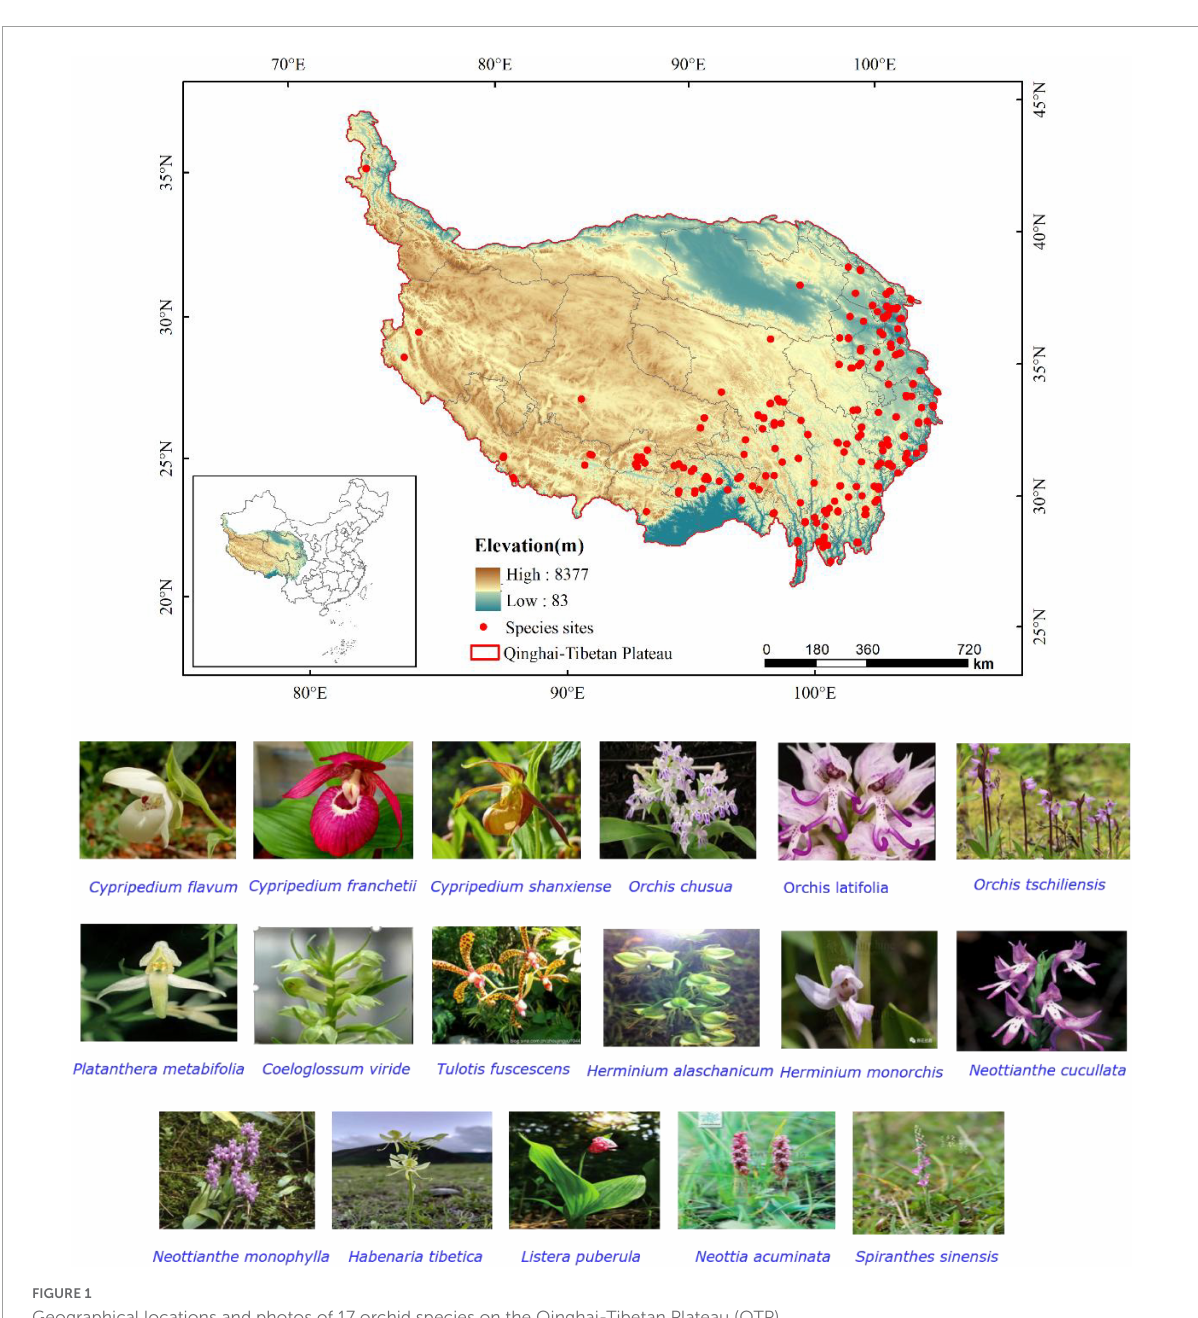
FIGURE1 Geographical locations and photos of 17 orchid species on the Qinghai-Tibetan Plateau